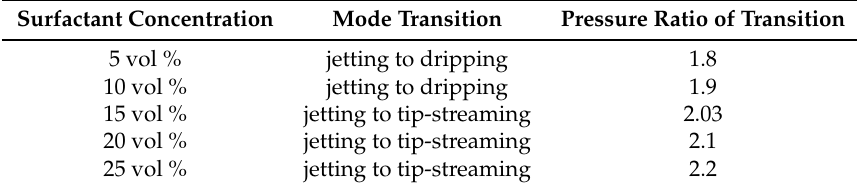
Table 1. The mode transition in the droplet breakup process.